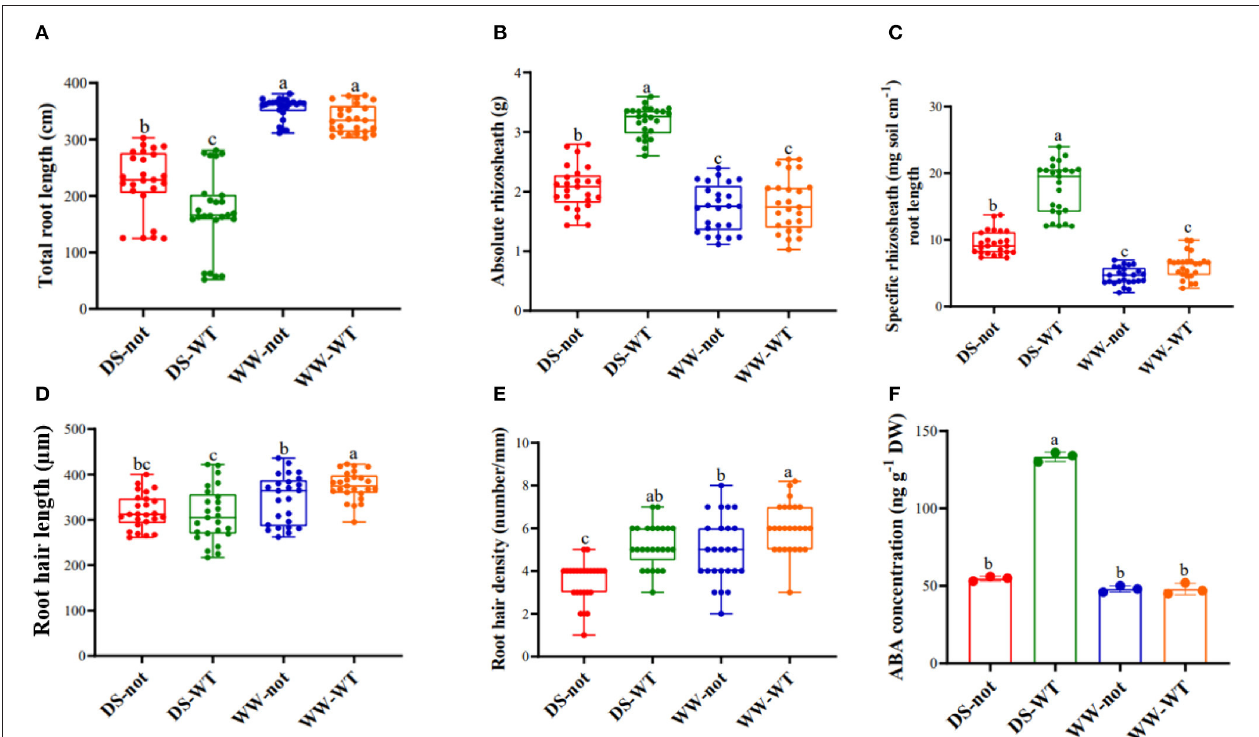
FIGURE 1 | Variation in (A) total root length; (B) absolute rhizosheath weight; (C) specific rhizosheath weight; (D) root hair length; (E) root hair density, and (F) root ABA concentration of WT and not plants under contrasting water regime conditions. Data are mean ± s.e. of 25 replicate plants (three replicates for ABA content). Different letters above the bars indicate significant differences at p ≤ 0.05. DS, drying stress; WW, well watered; not , notabilis ; WT, wild type.